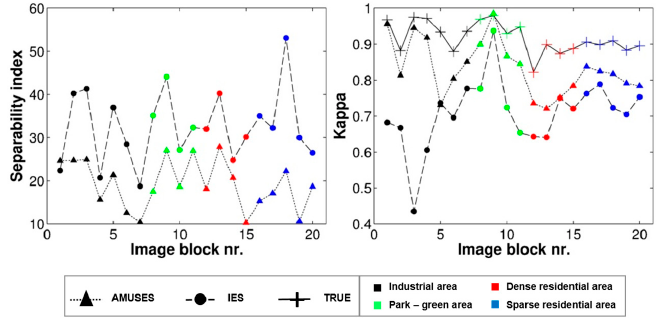
Figure 4. Performance comparison of IES and AMUSES pruning algorithms on the 20 image blocks of the Brussels dataset. Left: Spectral separability between pruned and true endmember libraries. Right: MESMA mapping accuracies (presented by kappa value) based on the respective libraries compared to using the true set of endmembers present in the image blocks (TRUE). Data points are color coded in function of the urban structure type of the image blocks.